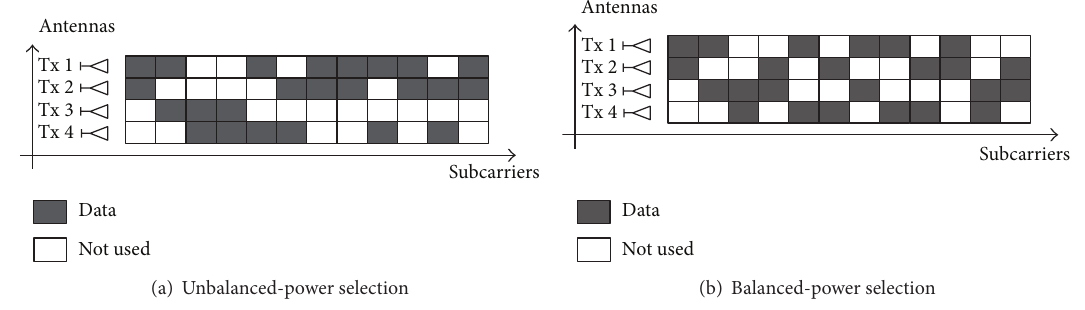
Figure 2: Illustration of per-subcarrier antenna subset selection (𝑛 𝑇 = 4,𝑛 𝐷 = 2, and 𝐾 = 12) .